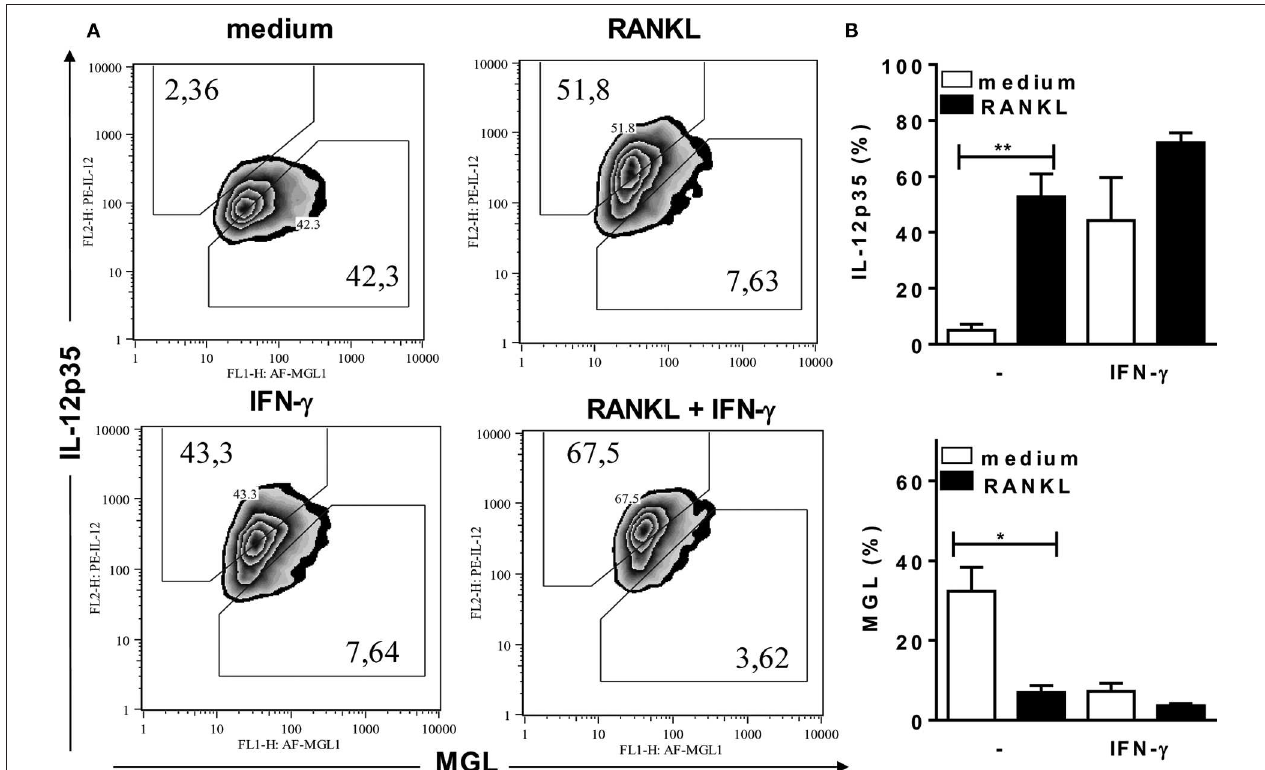
FIGURE 3 | RANKL induces a M2-like to M1 phenotype shift. Inflammatory (B6) macrophages were cultured in triplicates with medium or RANKL in the presence or absence of IFN- γ . After 48h, cells were harvested and stained with anti-F4/80, anti-CD301 (MGL), anti-IL-12p35, or control mAbs. (A) Plots depict F4/80 + cells as evaluated for CD301 (MGL) and intracellular IL-12p35 expression. (B) Results are expressed as means and S.E.M. Significant differences between macrophages treated with or without RANKL were analyzed by t -test and indicated for * P < 0.05, and ** P < 0.01. Data are representative of 2 independent experiments.